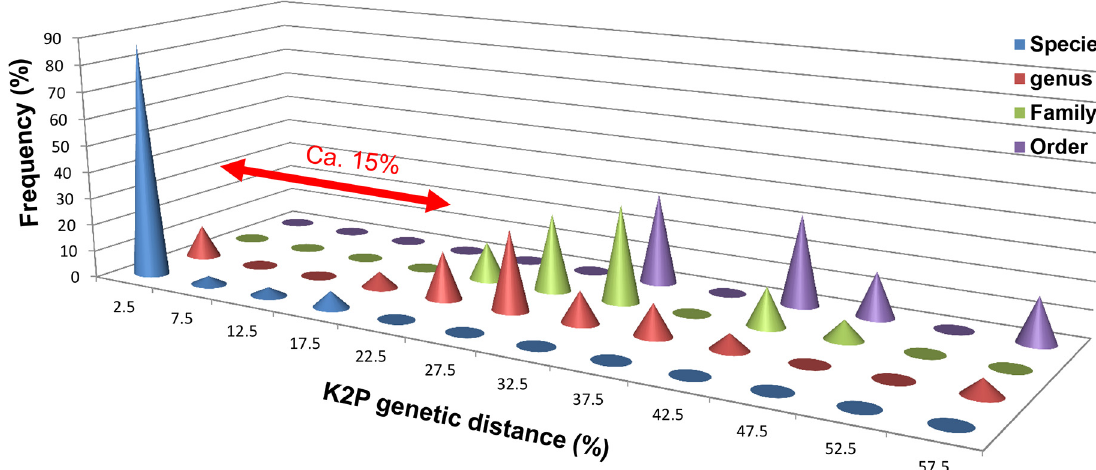
Fig 2. Distribution of pairwise genetic divergences estimated from nucleotide sequences of COI for 133 individuals of 94 copepod species including the six copepod orders based on the Kimura-2-parameter (K2P) distance matrix along four different taxonomic levels. The horizontal axis represents intervals of genetic distance in percentage and the vertical axis is the number of individuals associated with each distance interval. The flat box indicates zero value.